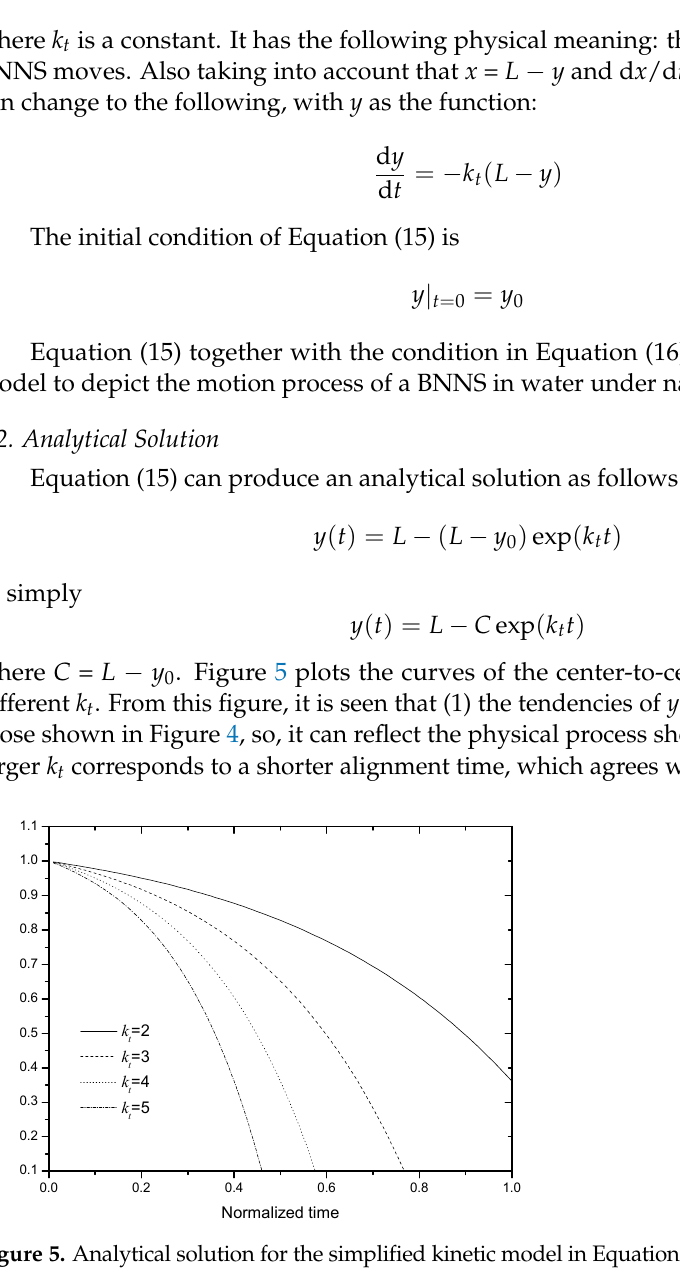
Figure 5. Analytical solution for the simpli fi ed kinetic model in Equation (17) when L = 1.1 and y 0 =